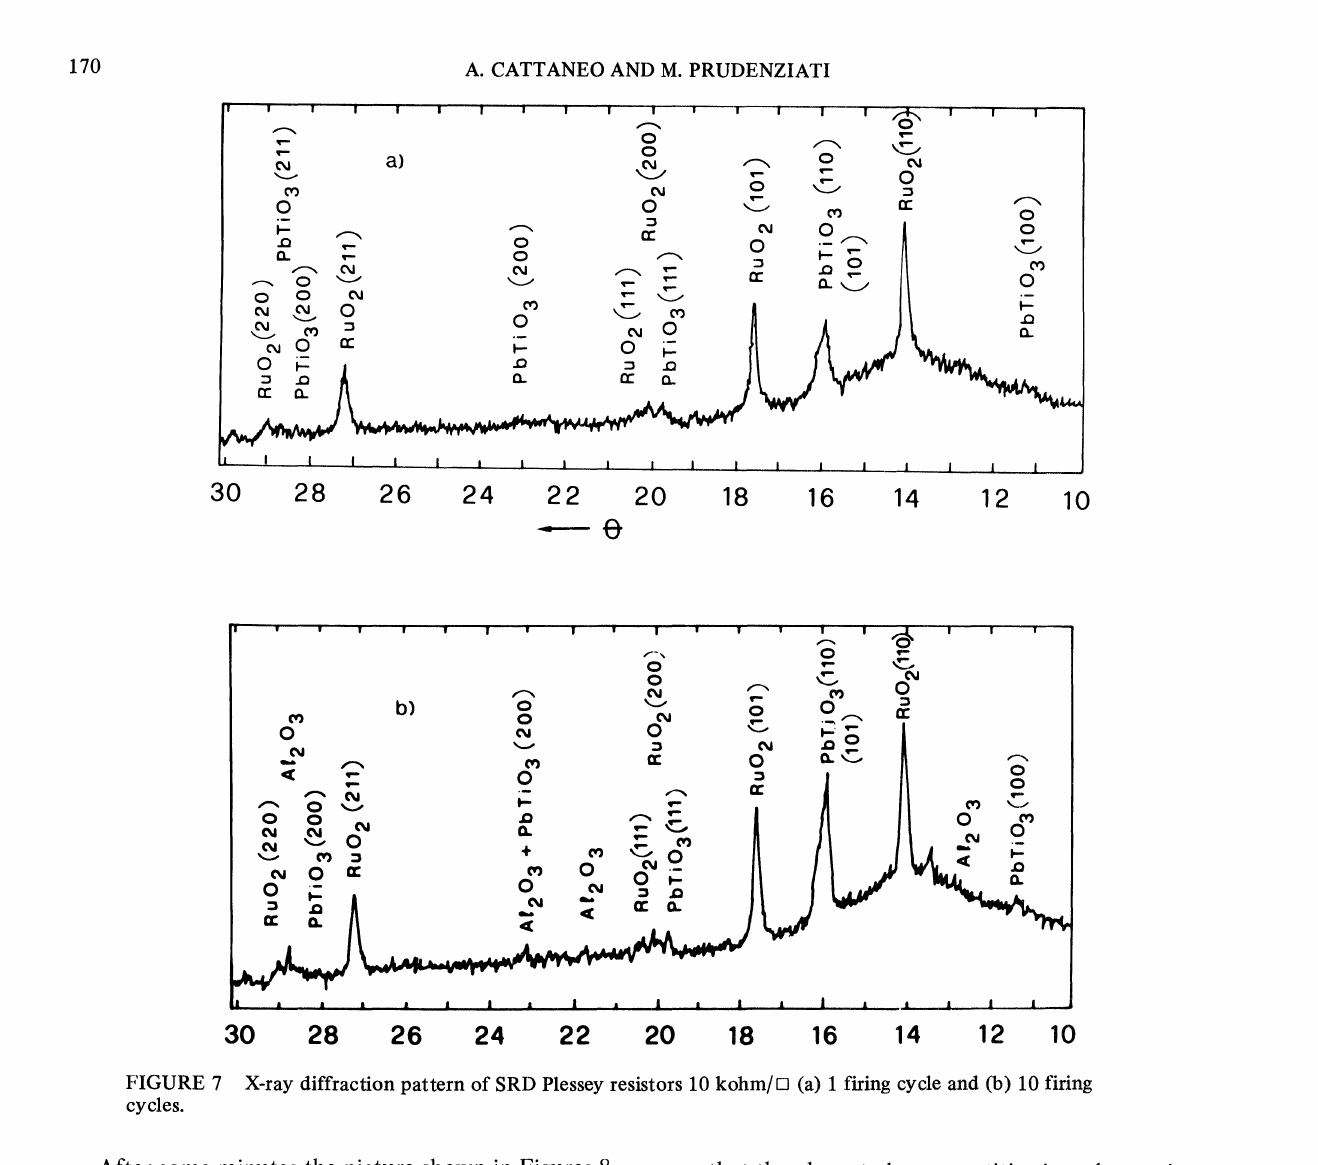
FIGURE 7 X-ray diffraction pattern of SRD Plessey resistors 10 kohm/E] (a) firing cycle and (b) 10 firing